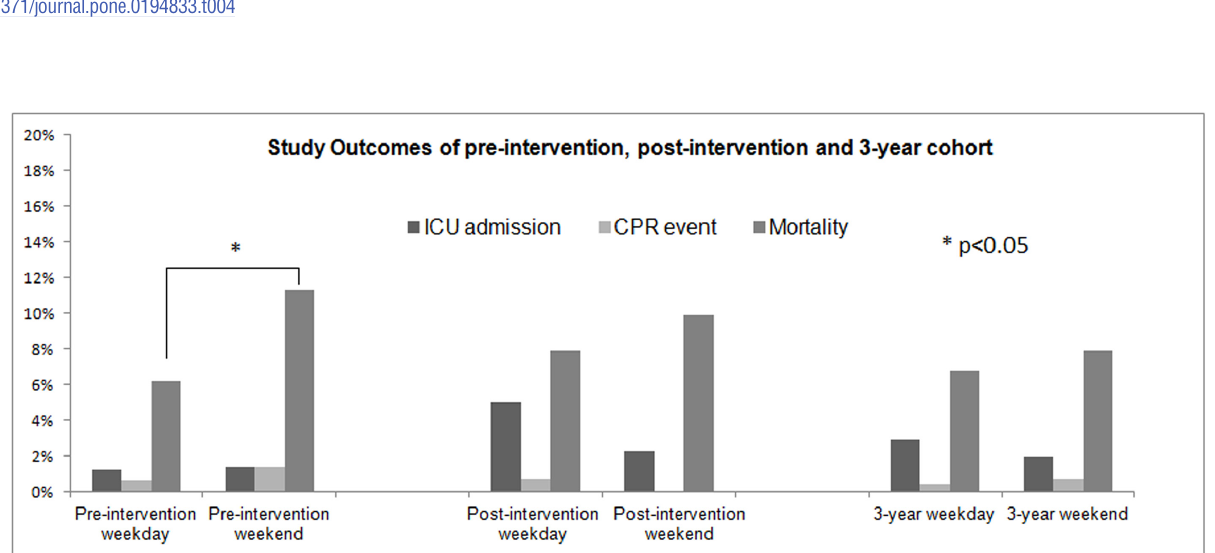
Fig 1. Study outcomes of pre-intervention, post-intervention and three-year follow-up cohort showed improved weekend versus weekday admission outcomes after